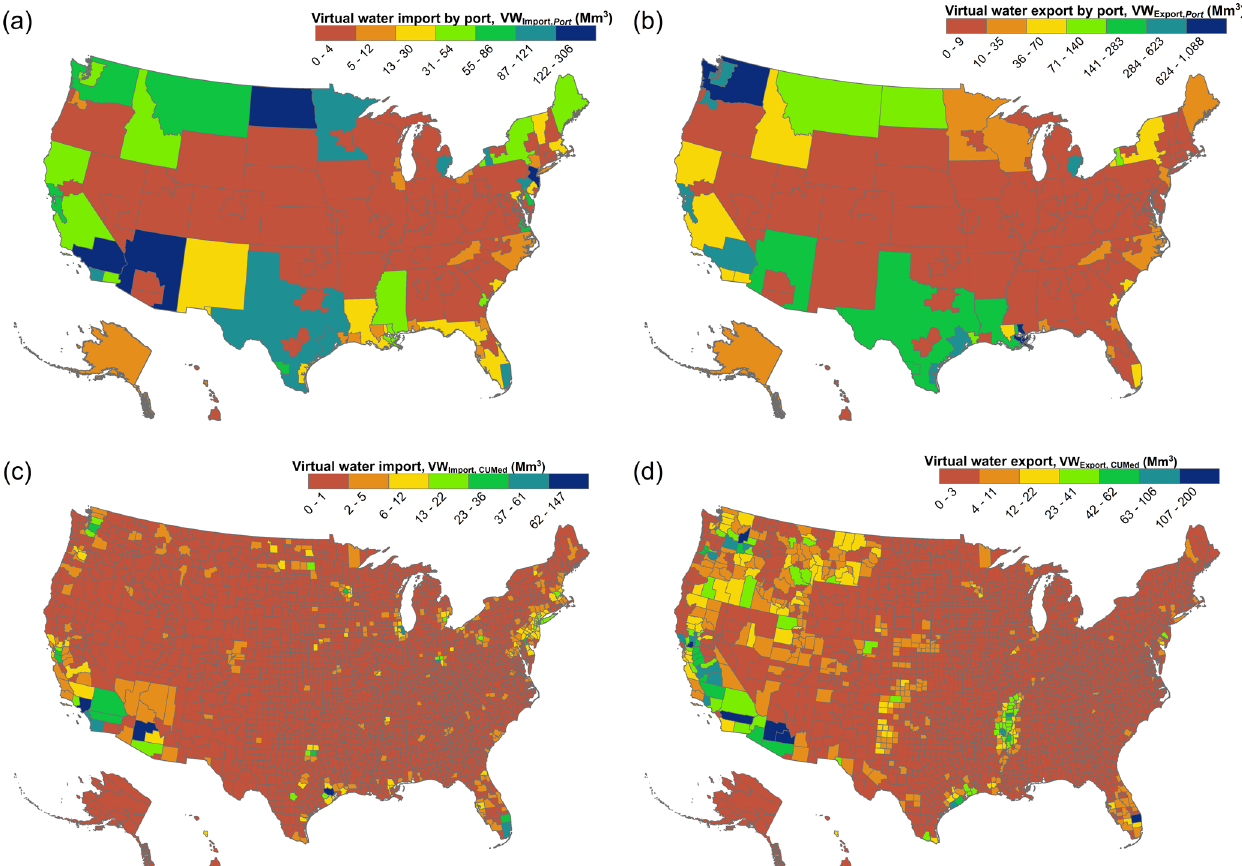
Figure 3. (a) The port and border regions through which the majority of US blue virtual water imports (CU Med ) enter the US market are primarily Los Angeles, New York, Arizona, North Dakota, Houston, Detroit, and Buffalo (FAZs are used for port region boundaries). (b) The ports through which the majority of US virtual water exports (CU Med ) enter the global market are located in natural hazard prone areas along the west coast, Gulf Coast, and eastern seaboard. (c) Cities such as Los Angeles, Phoenix, Houston, New York City, Miami, Dallas, Seattle, and the San Francisco Bay area are the major destinations of US virtual water imports (CU Med ). (d) US virtual water exports (CU Med ) originate from California’s Central Valley; southern California and southwestern Arizona; the Columbia River basin and the Pacific Northwest; Central Nevada and northwestern Utah; the Ogallala Aquifer region of the Midwest; the Texas Gulf Coast; the Mississippi Embayment; and southern